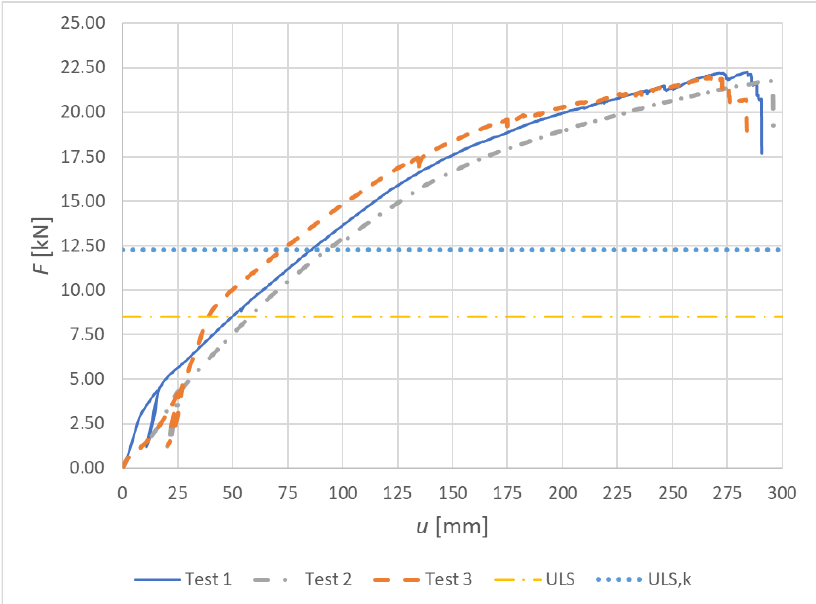
Figure 13. Experiment A: Load – deformation curves of destructive quasi-static cyclic testing for individual specimens made from a combination of bolts and dowels.